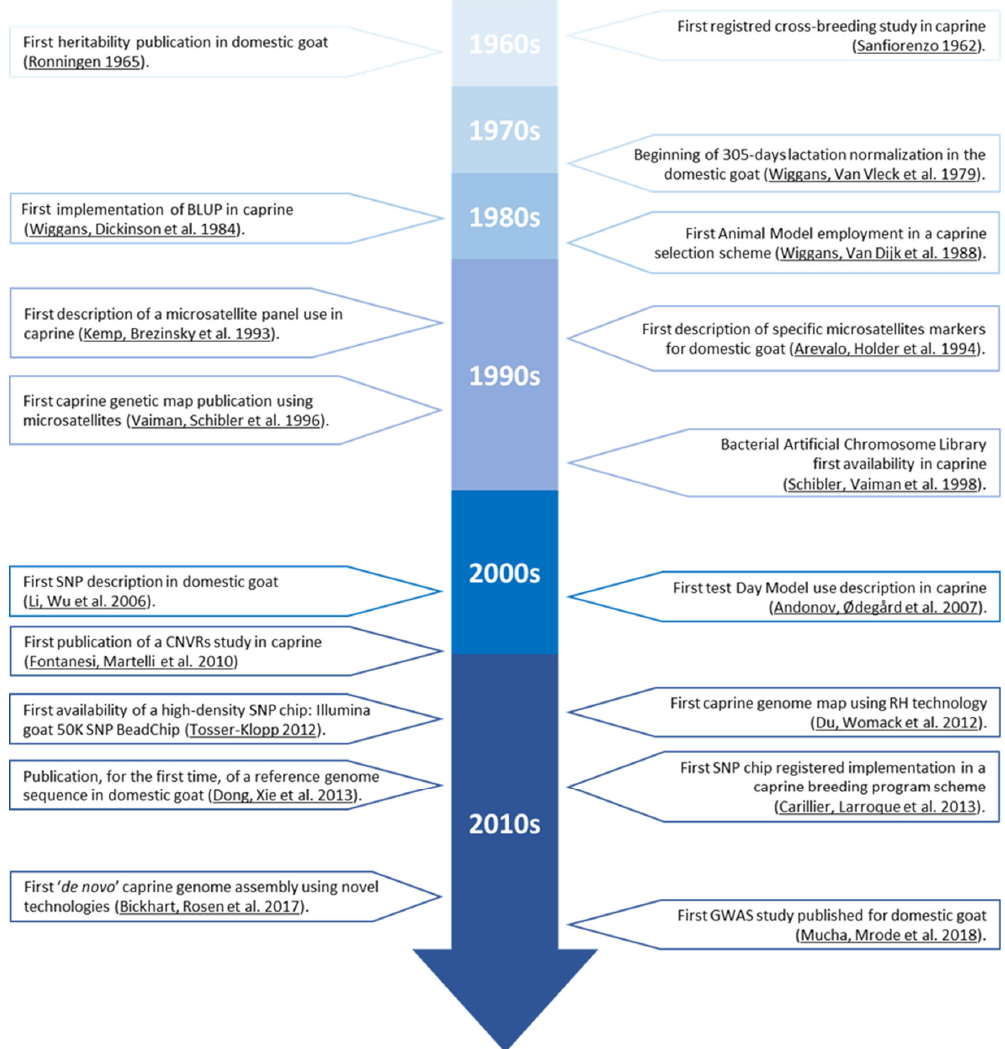
Figure 2. Timeline of caprine genetic advances milestones [16–18,20–33]